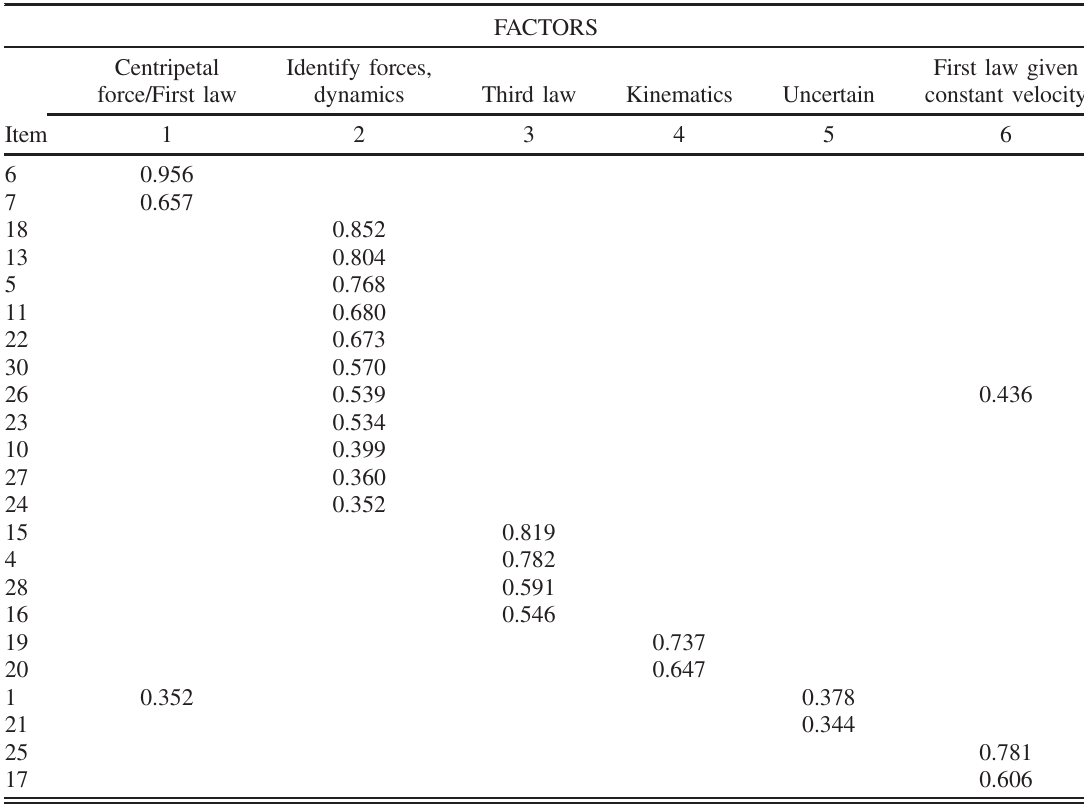
TABLE V. Here the absolute values of the loadings 0.340 and higher are shown for the model of Table IV. Three questions (8, 9, 12, and 14) had loadings below this value. Also, the question ordering reflects the ordering of the loading values. Here one sees an identification of all but one of the six factors with Newtonian concepts. Note that the third law factor includes all FCI questions that an expert would consider to be